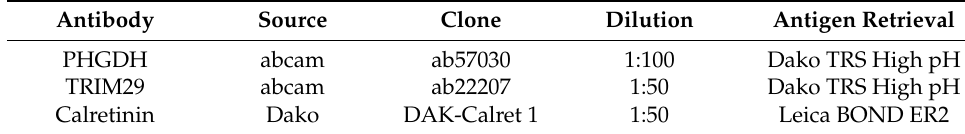
Table 2. Antibodies employed for immunohistochemistry